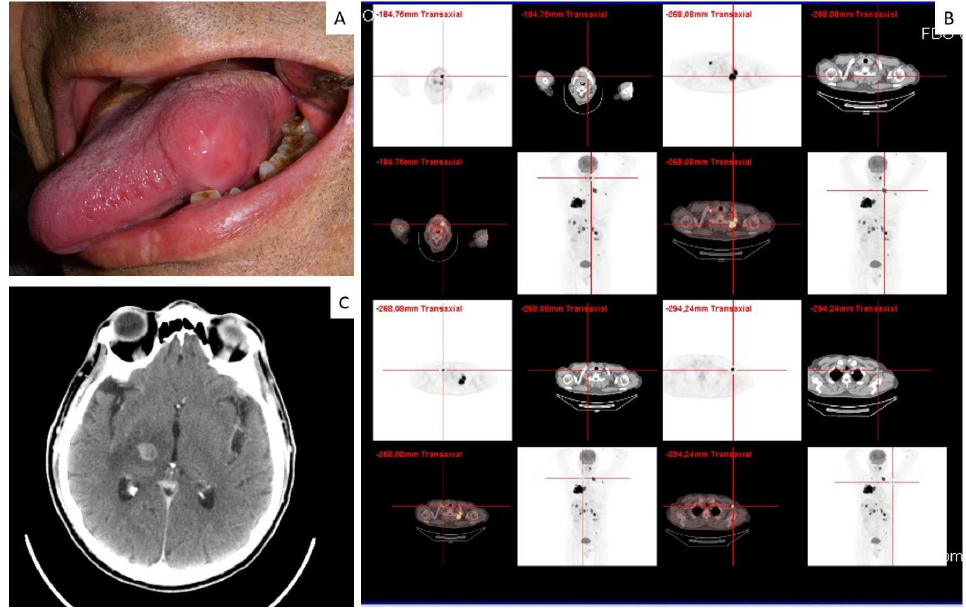
Figure 4. Metastatic lesion of the tongue ( A ) occurring in a patient already diagnosed with small cell carcinoma of the lung, as evident in PET scan ( B ), and with simultaneous brain metastasis ( C ). In the eight cases with head and neck metastases presenting as the first clinical sign of occult LC, the chest radiogram and/or computed tomography confirmed the presence of a still undetected lung nodule, compatible with primary LC and subsequently confirmed by a histological